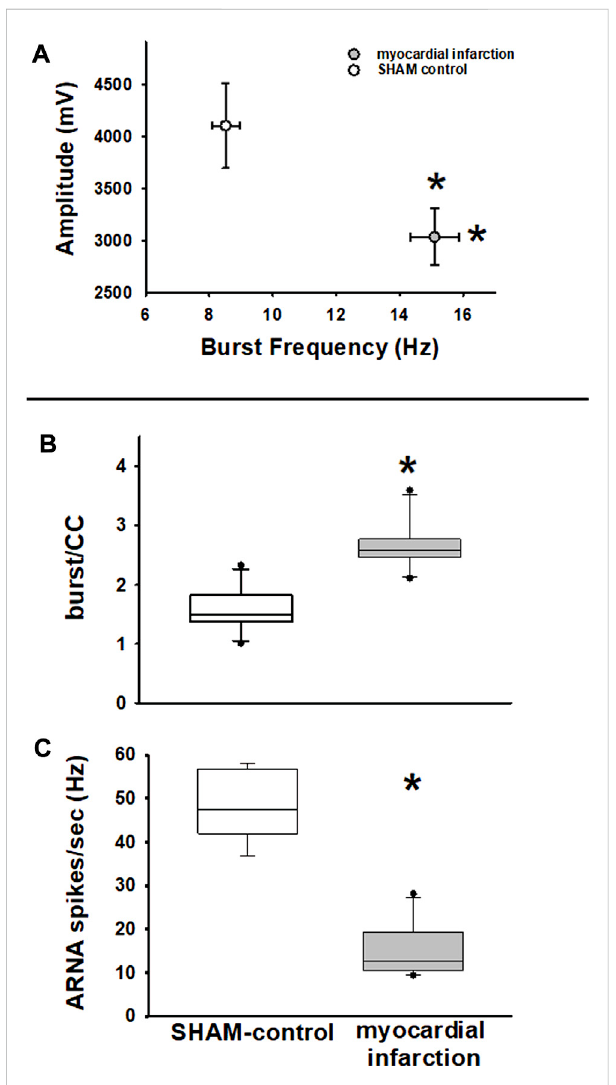
FIGURE 8 Efferent renal sympathetic nerve activity — frequency and amplitude. Upper panel (A) : renal sympathetic nerve activity (RSNA) burstamplitudeversusRSNAburstfrequency.RSNAburstfrequencyis higher in rats with myocardial infarction ( n = 11) versus SHAM controls ( n = 11, *p < 0.05), while RSNA burst amplitudes are lower (myocardial infarction vs. SHAM control, *p < 0.05, Kolmogorov – Smirnov test passed, t -test). Efferent renal sympathetic nerve activity and afferent renal nerve activity. Middle panel (B) : renal sympathetic nerve activity burst count per cardiac cycle (burst/CC) is higher in nephritic rats than in SHAM controls (myocardial infarction versus control, * p < 0.05, Kolmogorov – Smirnov test passed, t -test). Lowerpanel (C) :afferentrenalnerveactivityspikefrequency(spikes/s) is lower in rats with myocardial infarction than in controls (myocardial infarction vs. control, * p < 0.001, Kolmogorov – Smirnov test passed, t -test).